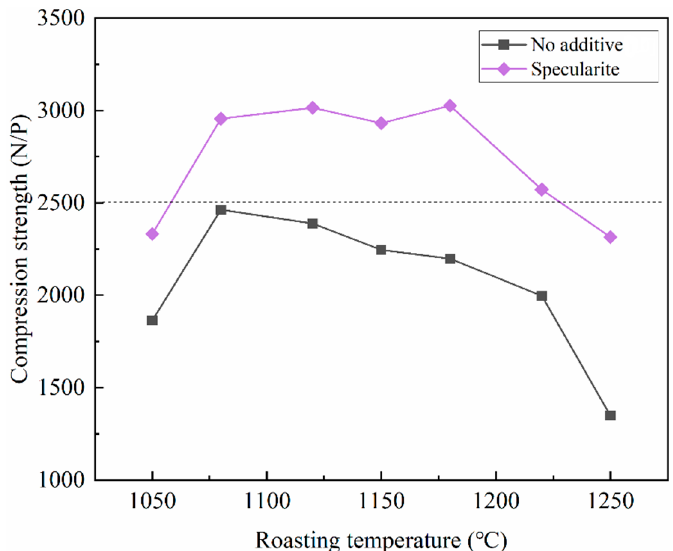
Figure 6. Effects of roasting temperature on compression strength of roasted pellets (preheating temperature 950 °C , preheating time 14 min, roasting time 10 min) (a horizontal dotted line at 2500 N/P is the first-grade qualified standard for blast furnace [20]).